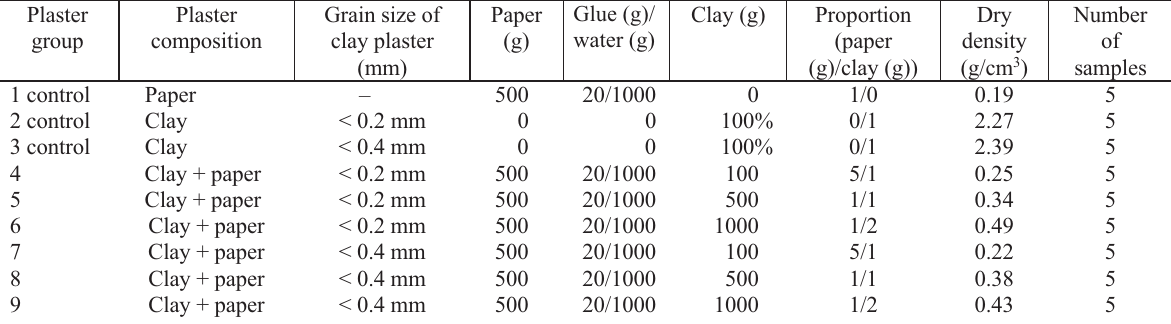
Table 1. Composition of mixtures